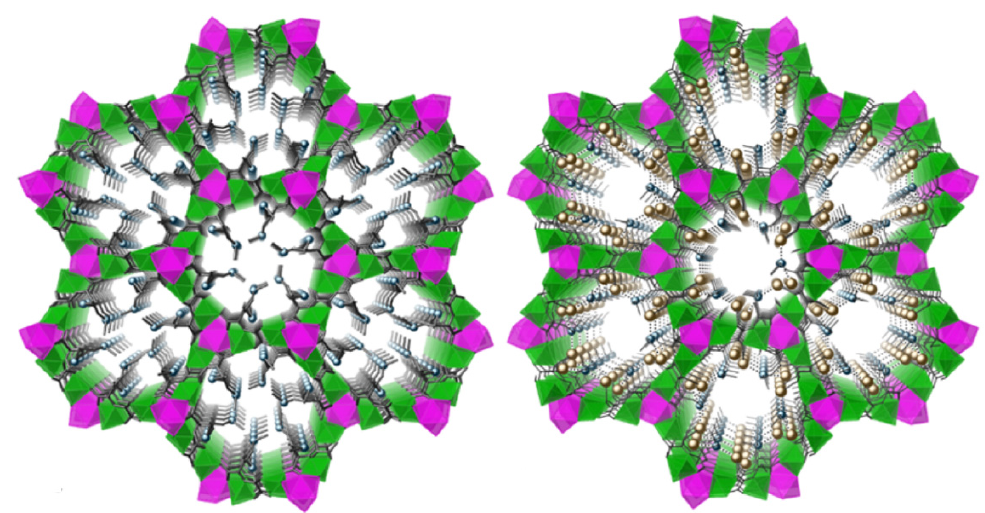
Figure 4. Structures of a MOF based on Ca 2+ and Cu 2+ employed for gold recovery ( left ), and its gold recovery product ( right ). Reproduced with permission from [68].